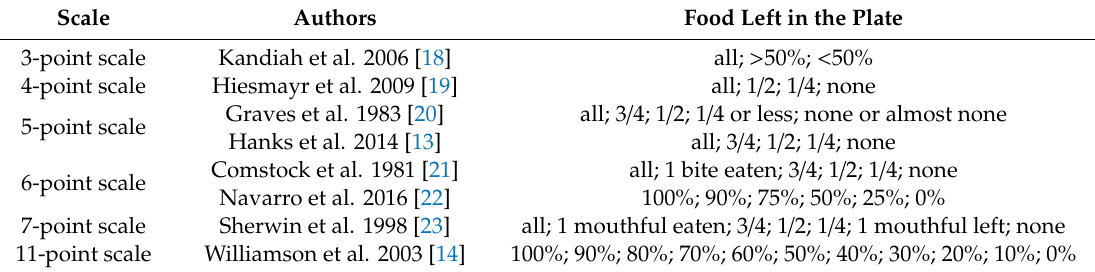
Table 1. Diversity of scales used to measure food waste through visual